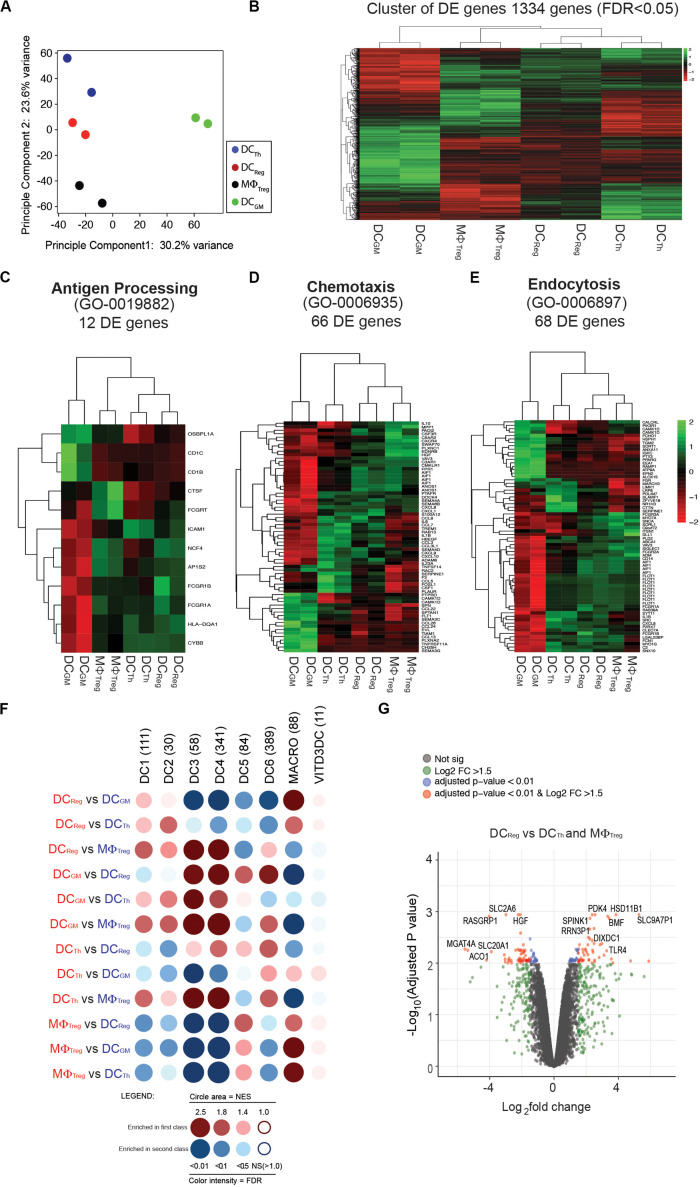
Transcriptomic profile of DCReg further distinguishes these cells from DCTh, MΦTreg and DCGM. (A) Principal component analysis (PCA) for DCTh, DCReg, MΦTreg and DCGM from each sample based on the mean expression of the genes with variable expression. (B) Cluster analysis of a total of 1334 differentially expressed genes [false discovery rate (FDR) < 0.05]. (C) Hierarchical clustering using sets of differentially expressed genes corresponding to the gene ontology biological functions of antigen processing (53 genes), (D) chemotaxis (73 genes), or (E) endocytosis (100 genes). (F) GSEA of the gene signature (GeneSet) of DCTh, DCReg, MΦTreg and DCGM. GSEA results for pairwise comparisons between human blood CD141+Clec9A+ (labeled as DC1), CD1c_A (DC2), CD1c_B (DC3), CD141–CD1c– DCs (DC4), pDCs (DC6), DC5/AS DCs (DC5), macrophage (MACRO), and VITD3DC gene sets. Dot blot representation of all pairwise GSEA comparisons. GeneSets comprise different number of genes (n). Dot color corresponds to the font color of the population in which the GeneSet is enriched. The dot area is proportional to the NES (Normalized enrichment score) which varies from 1 (no enrichment) to a maximum of 5. The color intensity is indicative of the FDR statistical q value, which estimates the likelihood that the enrichment of the GeneSet represents a false-positive finding. (G) Volcano plot representation of microarray data. DCReg vs. DCTh and MΦTreg were plotted according to the log2 fold change (X axis) and log10 adjusted p-value (Y axis). Log2FC represents the absolute value of log2 fold change. Log2FC and p value was calculated with the Benjamini-Hochberg (BH) method.